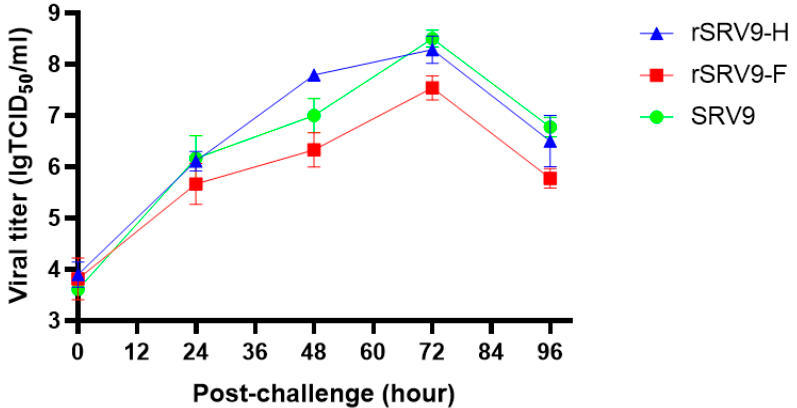
Figure 6. Growth kinetics assay of recombinant viruses rSRV9-H and rSRV9-F. At 0, 24, 48, 72, and 96 h after infection with recombinant viruses, 200 μ L of the supernatant was collected, and virus titers were determined by TCID 50 at 5 timepoints.